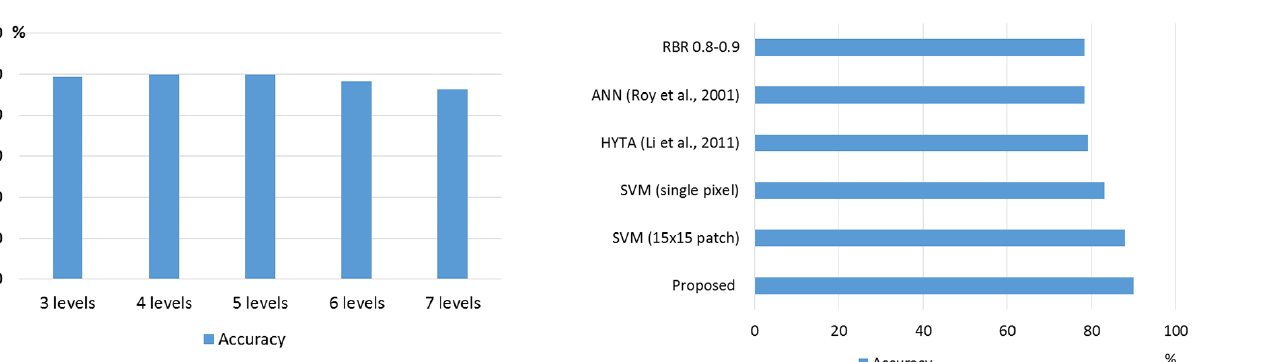
Figure 10. Comparisons of different